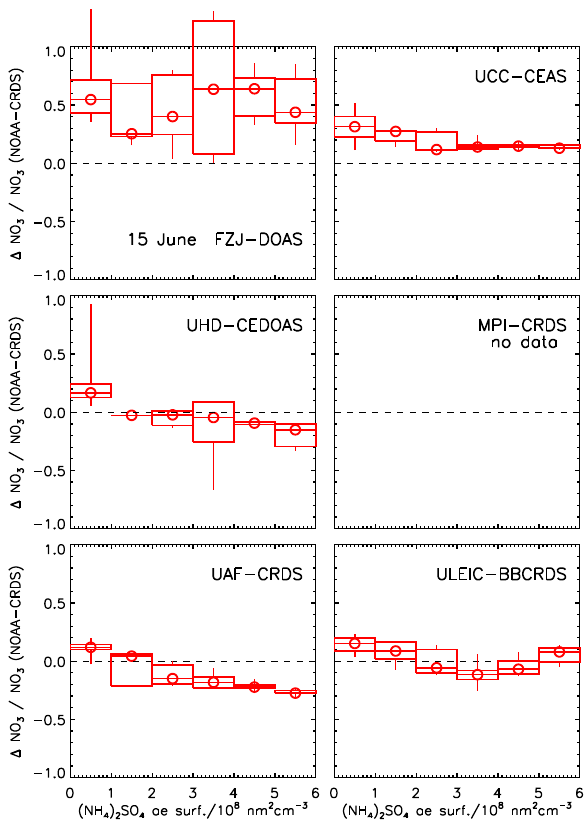
Fig. 11. Box-and-whisker plot of the relative difference of NO 3 measurements between various instruments and the reference NOAA-CRDS as function of the surface of ammonium sulphate aerosol during the “inorganic aerosol” experiment on 15 June. Dots are medians, boxes give the first and third quartile and whiskers de- note the 10th and 90th percentiles.